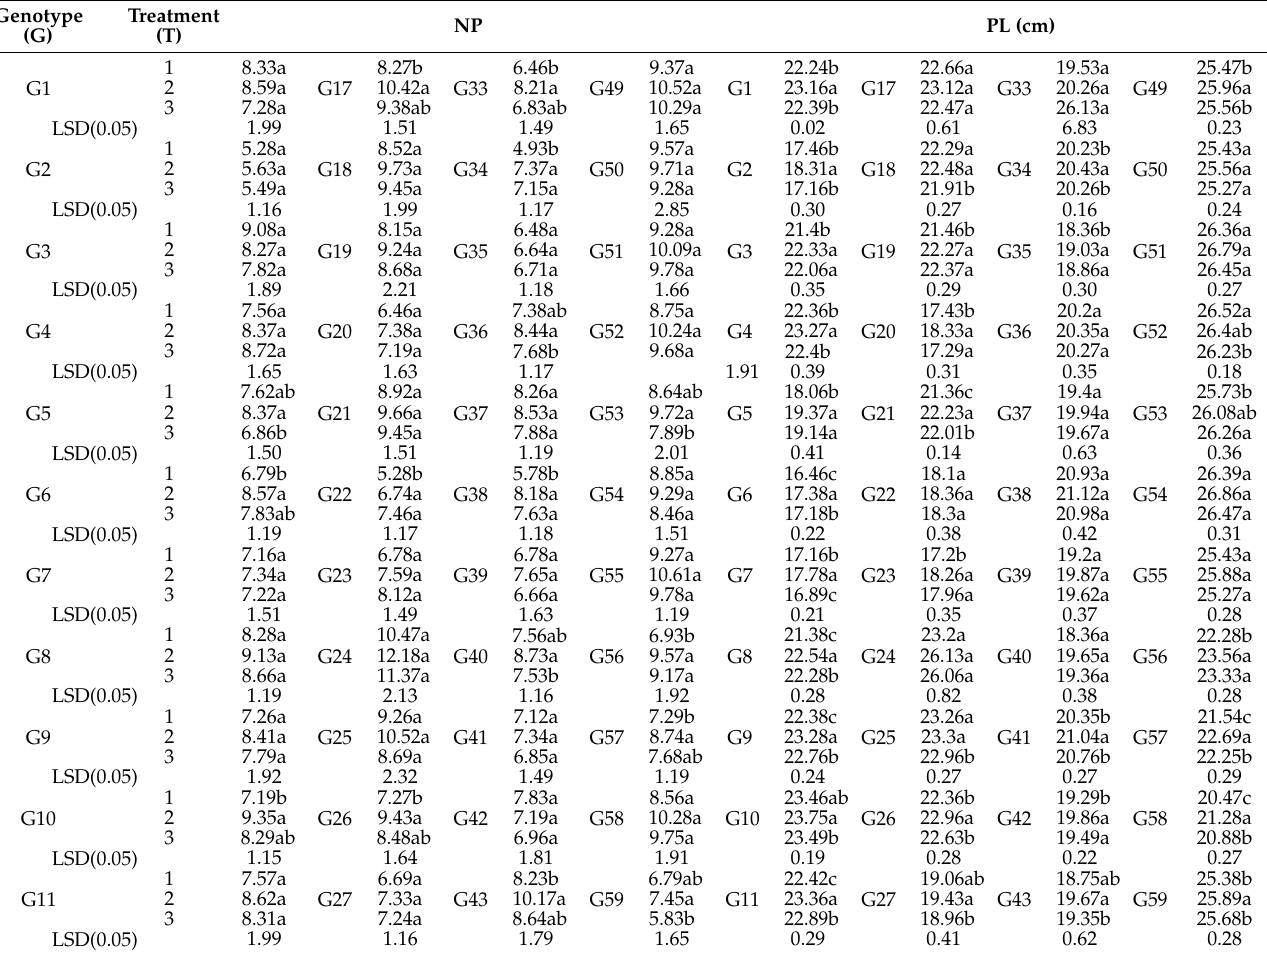
Table 7. Number of panicles per hill and panicle length of 64 rice genotypes as influenced by treatment and genotype (pooled over two